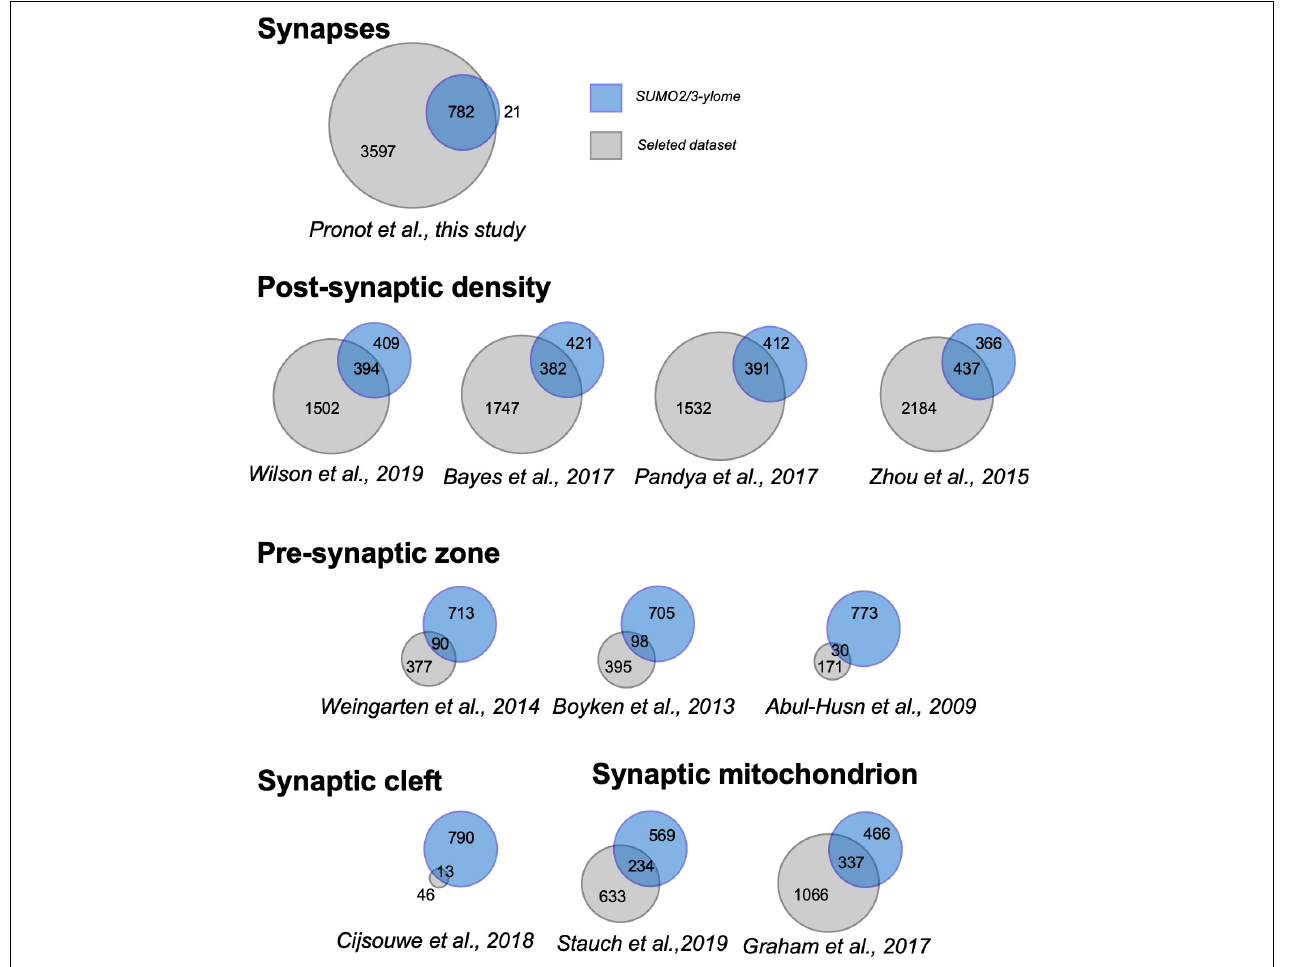
FIGURE 2 | Venn diagrams showing overlap between the synaptic SUMO2/3-ylome and the indicated proteomes. Numbers indicate the number of proteins specifically present in the present study (blue), in the referenced previous studies (gray) and at the intersection of the protein sets. Details in the